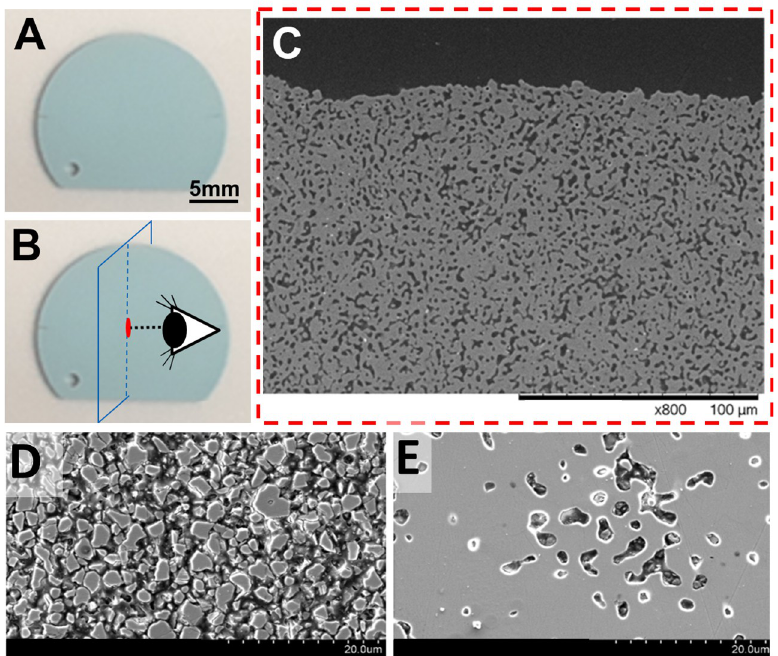
Fig 2. Scanning Electron Microscopy (SEM) of DLP print builds. (A) Macro view of coupons built using DLP process, which were rinsed with a propylene carbonate/tripropylene glycol blend and then fired. Micro view and analysis of coupons using SEM imaging was conducted on coupons (B) transversely sectioned mounted and polished, (C) revealing innate porosity. (D) SEM image of coupon before firing (green state, not sintered) reveals particle size of LithaBone HA400 ~2–6 microns and (E) after firing (heat treatment at 1300˚C),densification of particles is seen as a result of sintering.